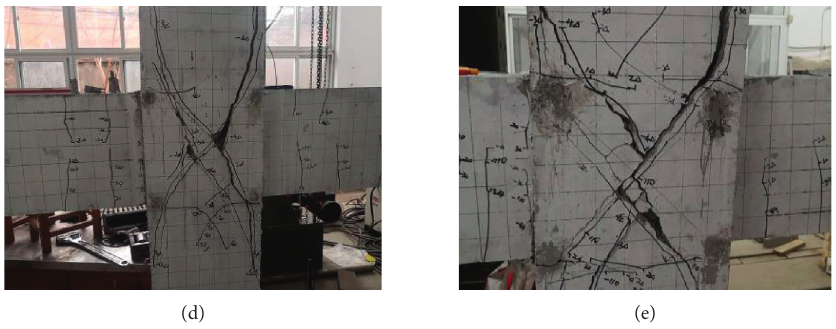
Figure 7: Crack distribution of components. (a) J-1, (b) J-2, (c) J-3, (d) J-4, and (e)